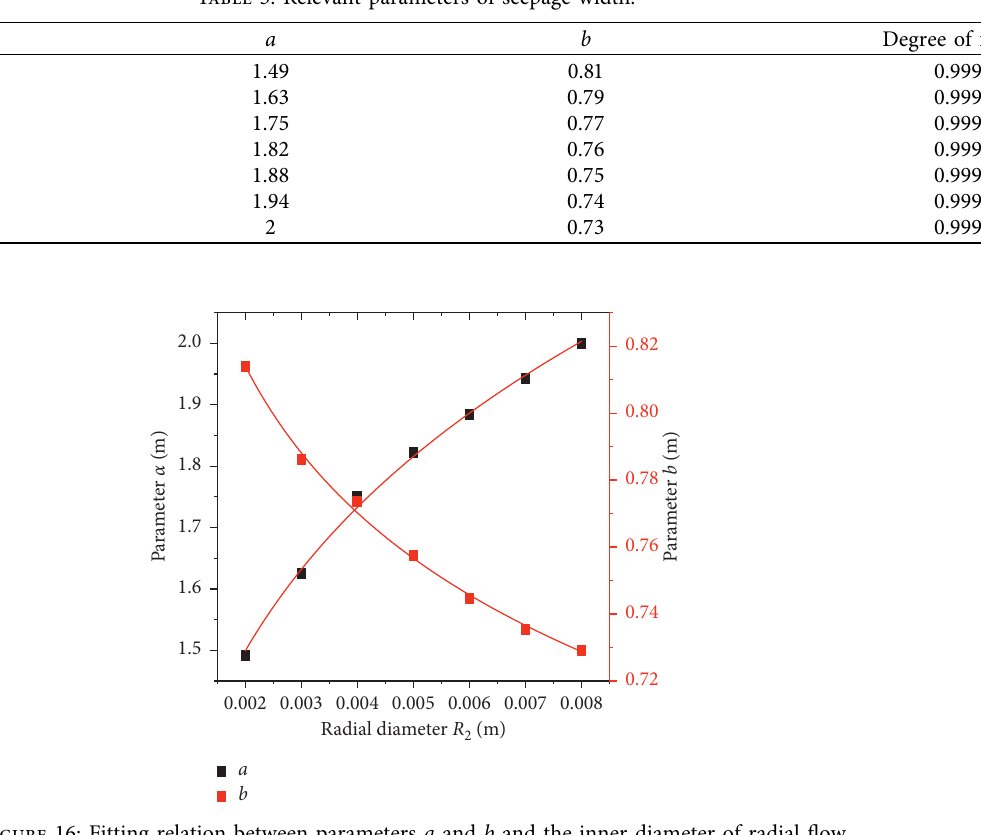
Table 5: Relevant parameters of seepage width.